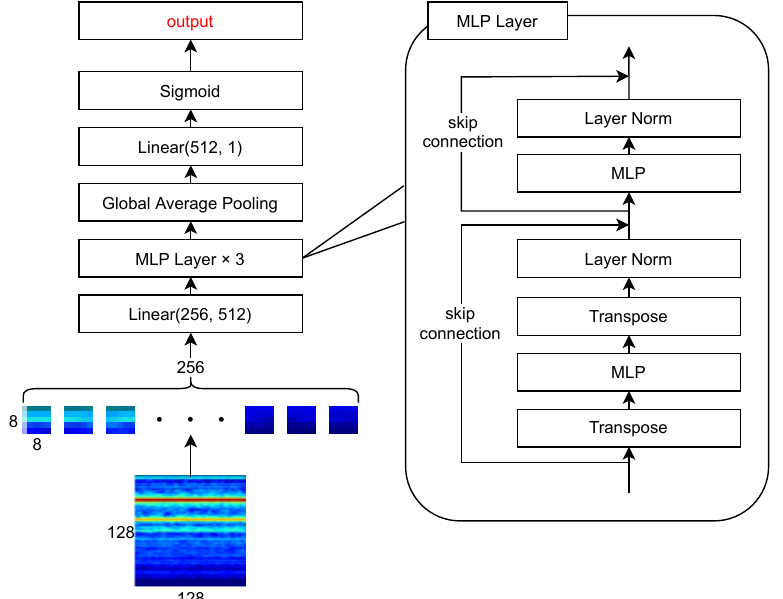
Figure 7. Structure of the parameter estimation model. We used the MLP-Mixer as the base of the model. The model estimates a single control parameter from a log-mel spectrogram image generated from a recording. The output from the model was a value between 0 and 1, corresponding to the magnitude of the estimated